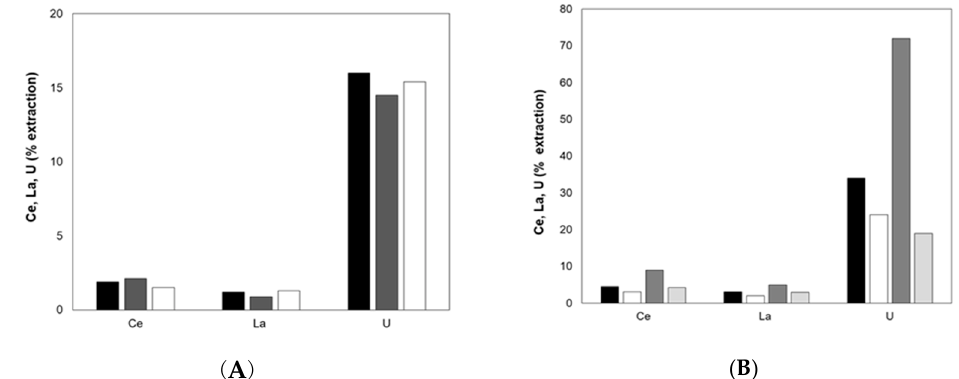
Figure 3. Percentages of cerium, lanthanum, and uranium extracted from the laterite ore, determined from the concentrations of these metals present in leachates at the end of the experiments. ( A ) A. ferrooxidans at pH 1.8, sparged with OFN (black bars) or with OFN/CO 2 (dark grey bars) and the corresponding abiotic control (white bars); ( B ) A. thiooxidans at pH 1.2 (black bars) and the corresponding abiotic control (white bars), and at pH 0.9 (dark grey bars) and the corresponding abiotic control (light grey bars). Note: the axis scales show the differences obtained under the anoxic and aerobic conditions using Acidithiobacillus species.